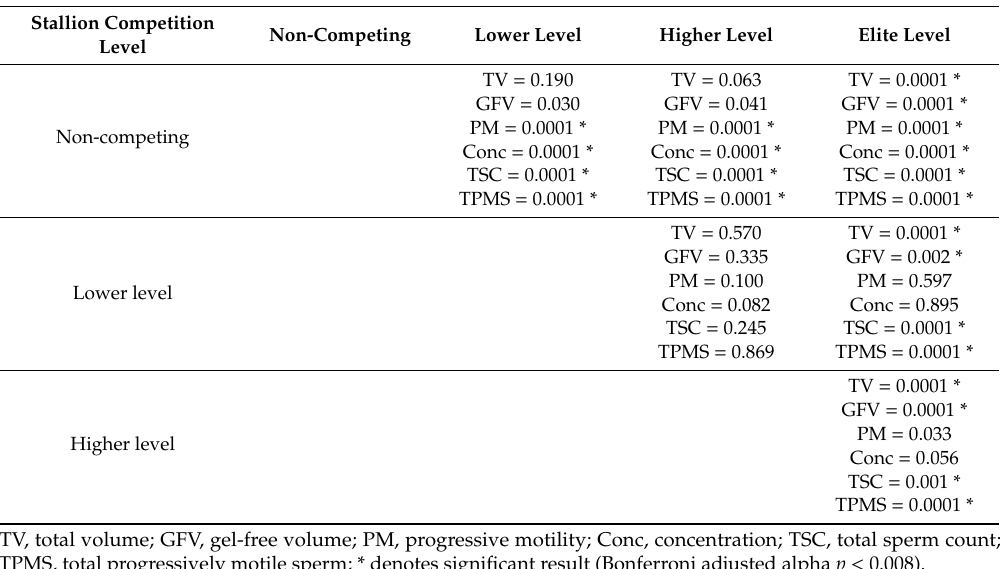
Table 6. Pairwise comparisons to identify where di ff erences in semen characteristics occur among stallion competition